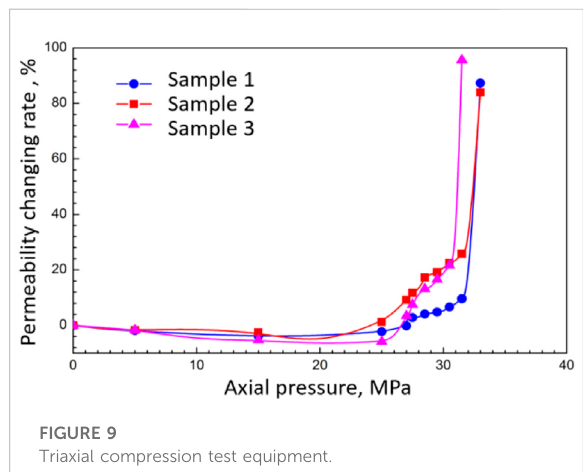
FIGURE 9 Triaxial compression test